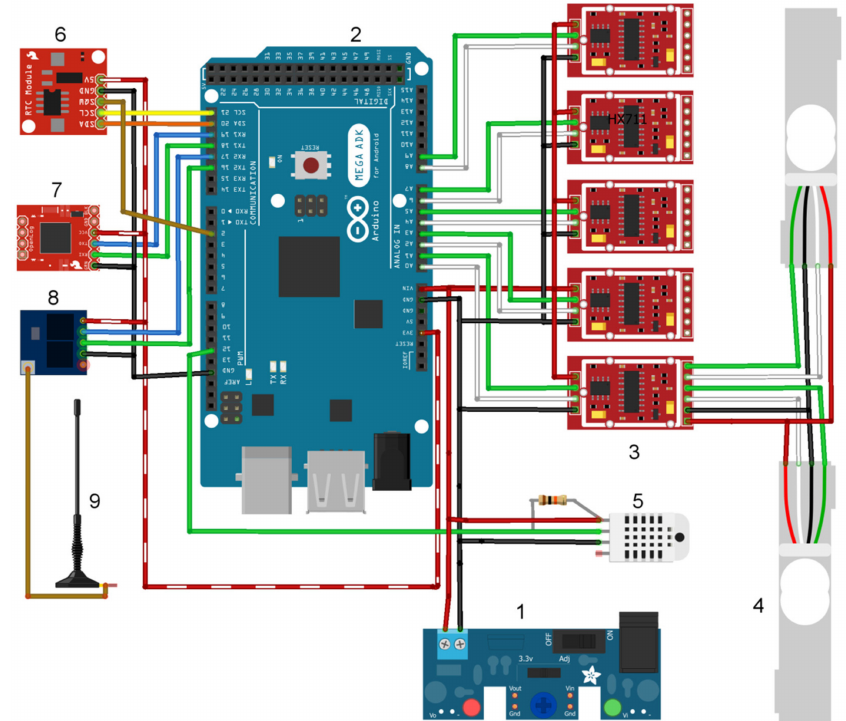
Figure 2. Smart sensors system structure. 1 : Power supply; 2 : Arduino Mega 2560 R3; 3 : Load Cell Amplifier HX711; 4 : Load Cell; 5 : Digital temperature and humidity sensor DHT22; 6 : Real- time clock DS3231; 7 : OpenLog Data Logger; 8 : Transceiver Wireless Module ESP8266-05; 9 : External